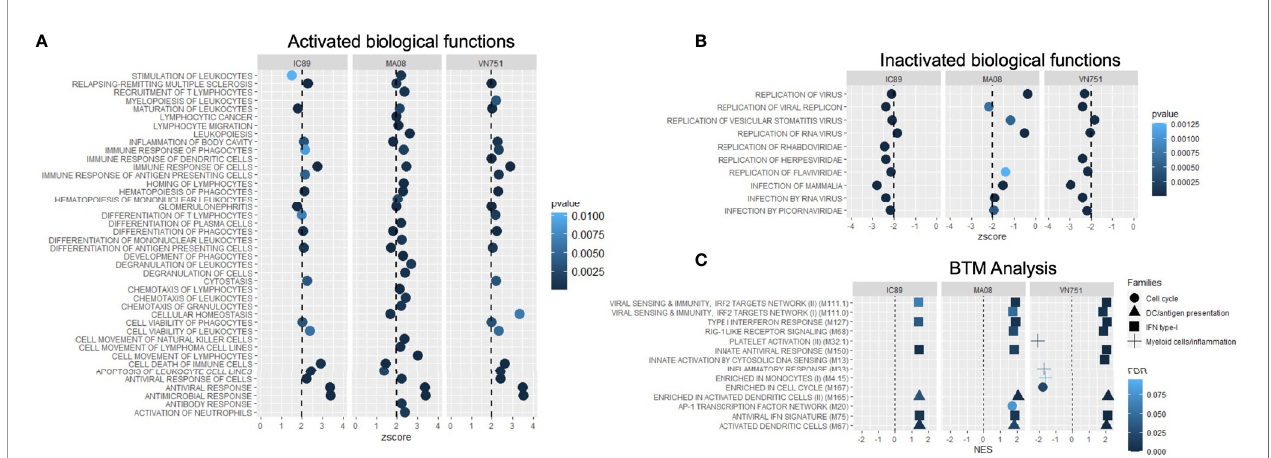
FIGURE 5 | Analysis of the activation of biofunctions and BTMs during PPRV infections at 72 hpi. Activated (A) and inactivated (B) biofunctions were found during the analysis. Qiagen ’ s IPA software provided a zscore that determines the activation (zscore>2) and the inactivation (zscore<-2) status of biological functions. All inactivated functions represent virus infection and replication functions and therefore re fl ect the induction of antiviral activities in the cells. (C) Analysis of goat blood transcriptional modules (BTMs) during PPRV infections of PBMCs at 72 hpi. Goat BTMs were activated or inactivated during infections (signi fi cance level: FDR < 0.1). Positive normalised enrichment score (NES > 0) means activation of a set of genes while negative NES (NES < 0) means